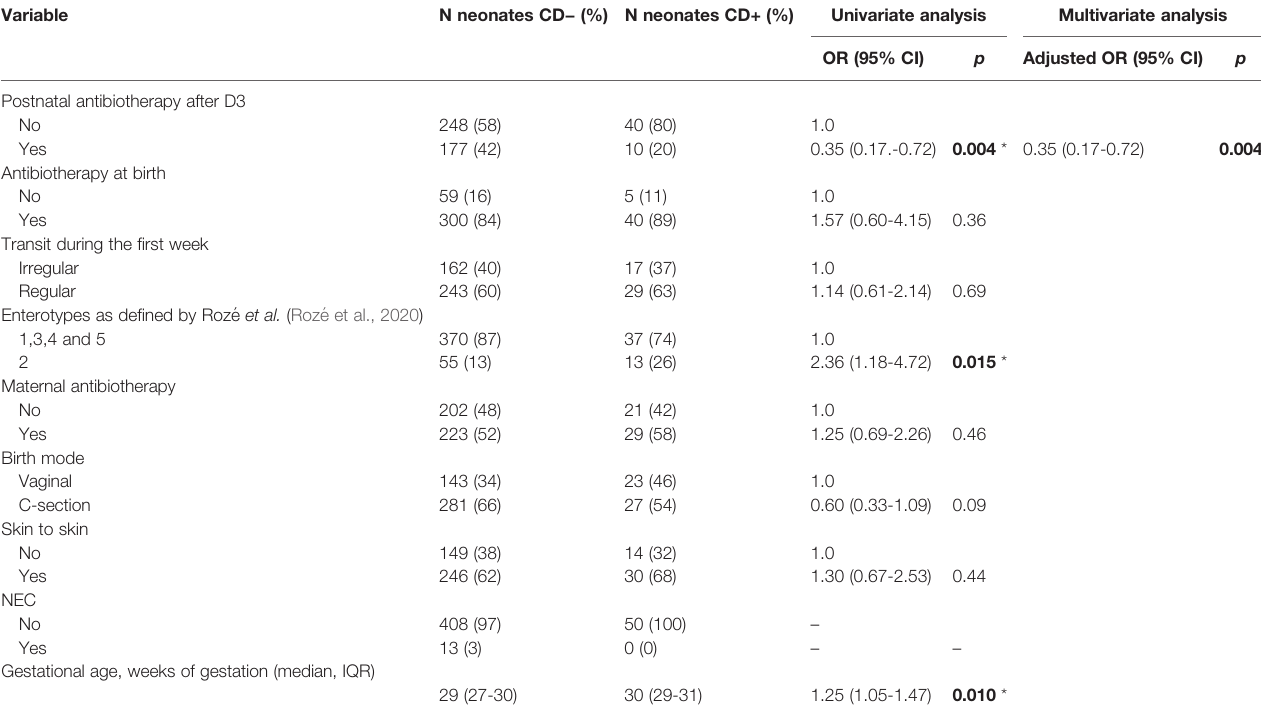
TABLE 2 | Factors associated with C. dif fi cile colonization at 1 month in the EPIFLORE cohort. Variable